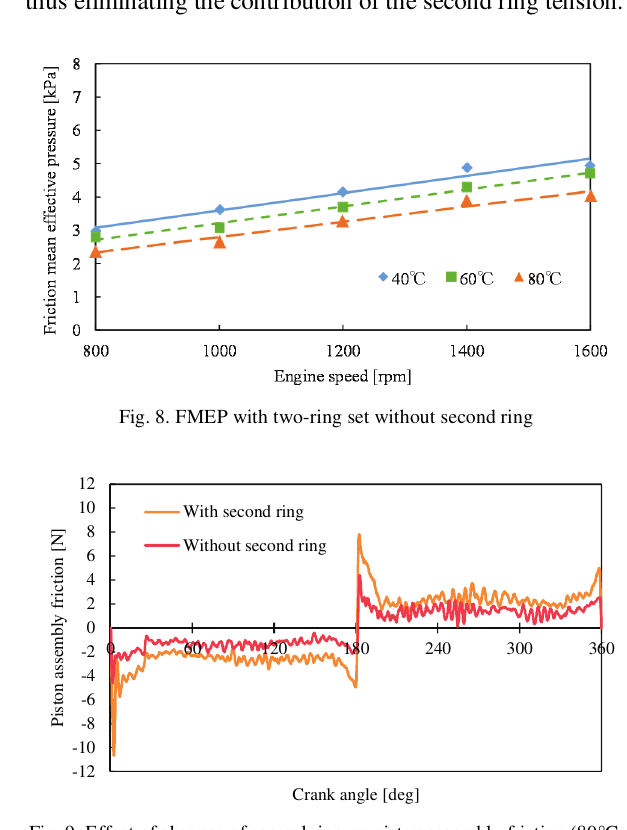
Fig. 9. Effect of absence of second ring on piston assembly friction (80°C, 1000